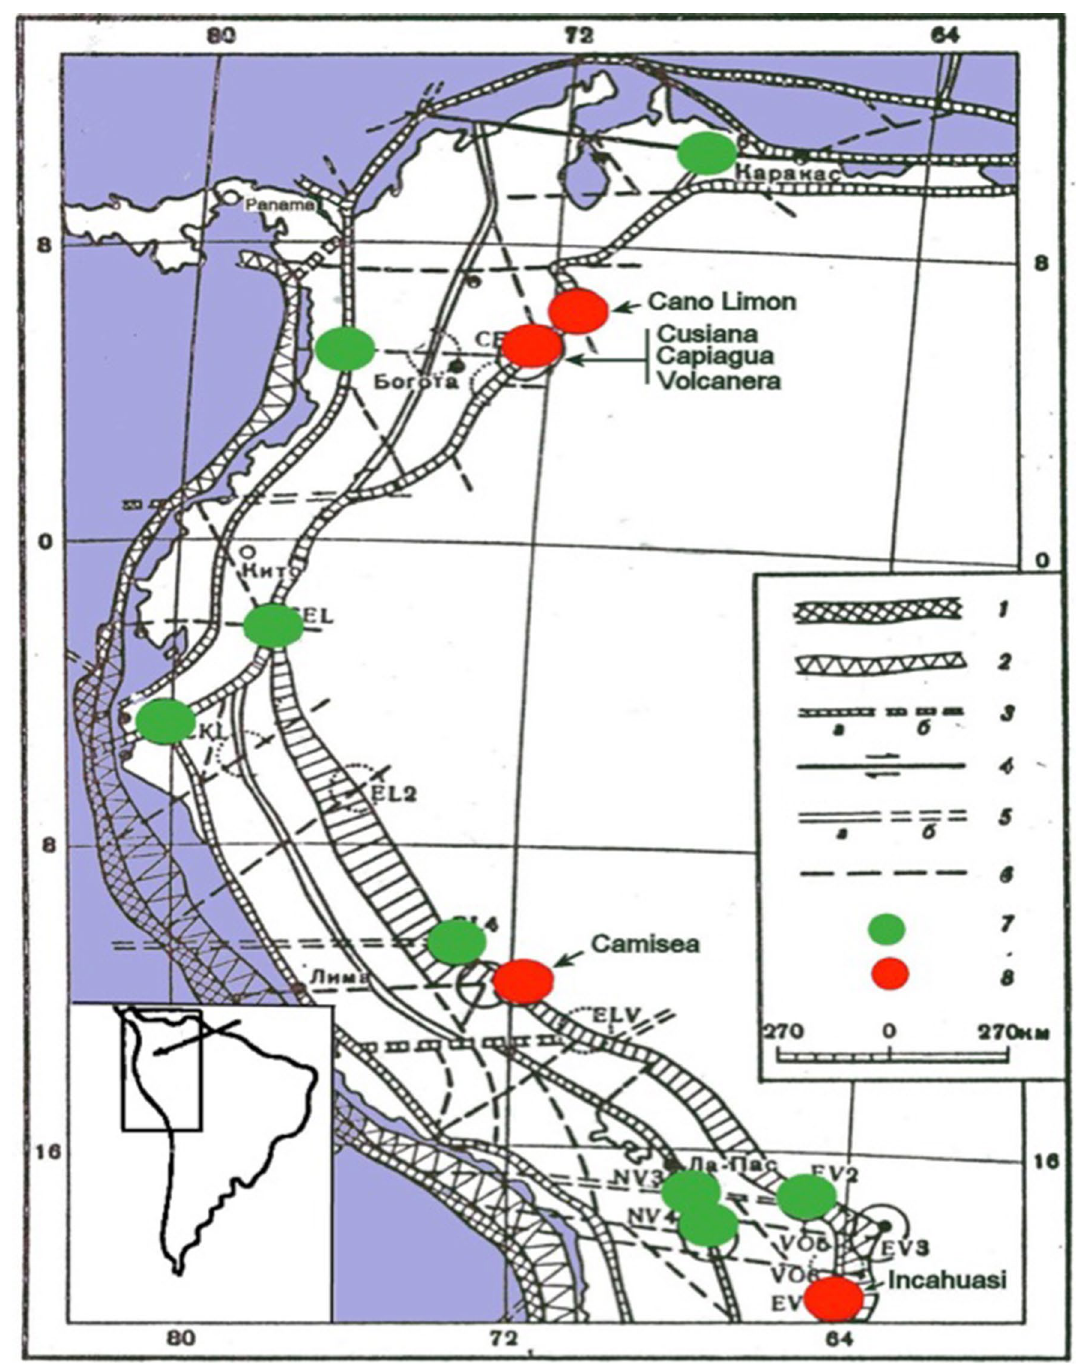
Fig. 1 Original prognostic map of the Andes of South America (Northern part) (Guberman et al. 1986). Morphostructural linea- ments: 1—deep-sea trench, 2—continental slope, 3—first rank line- ament, 4—main strike–slip faults, 5—second rank lineament, 6—